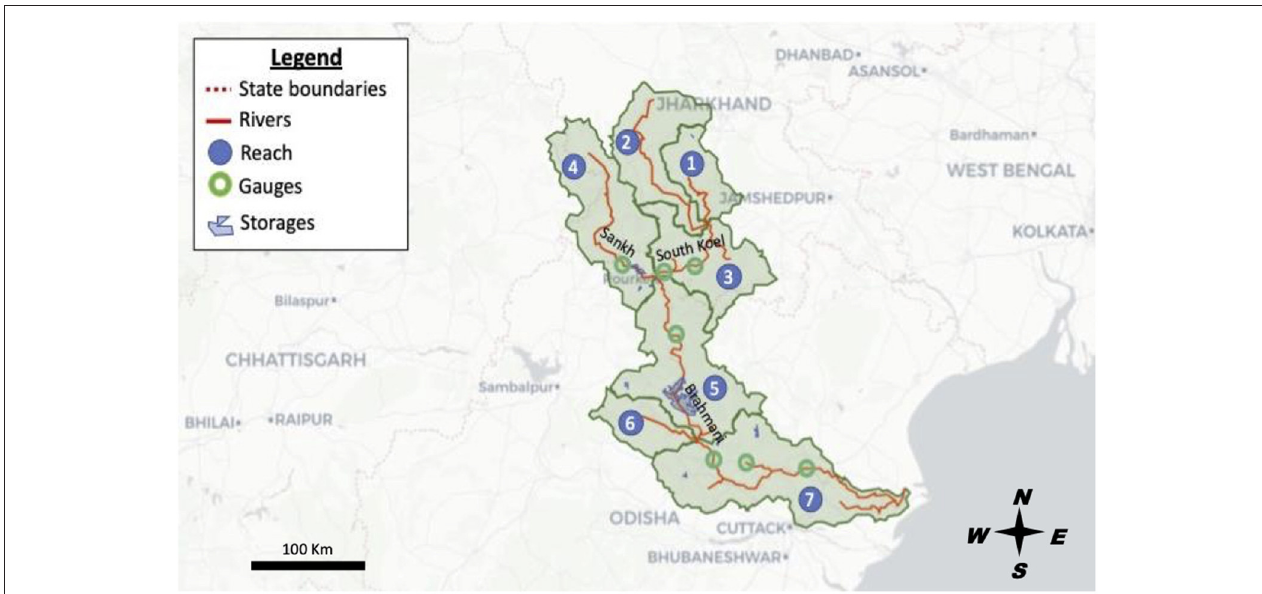
FIGURE 2 | Representation of the BRB system and its seven reaches in Basin Futures. The numbers identify the reaches to parameterize and associated outputs from the tool. The upstream state of Jharkhand is represented by reaches 1–4; the downstream state of Odissa by reaches 5–7.